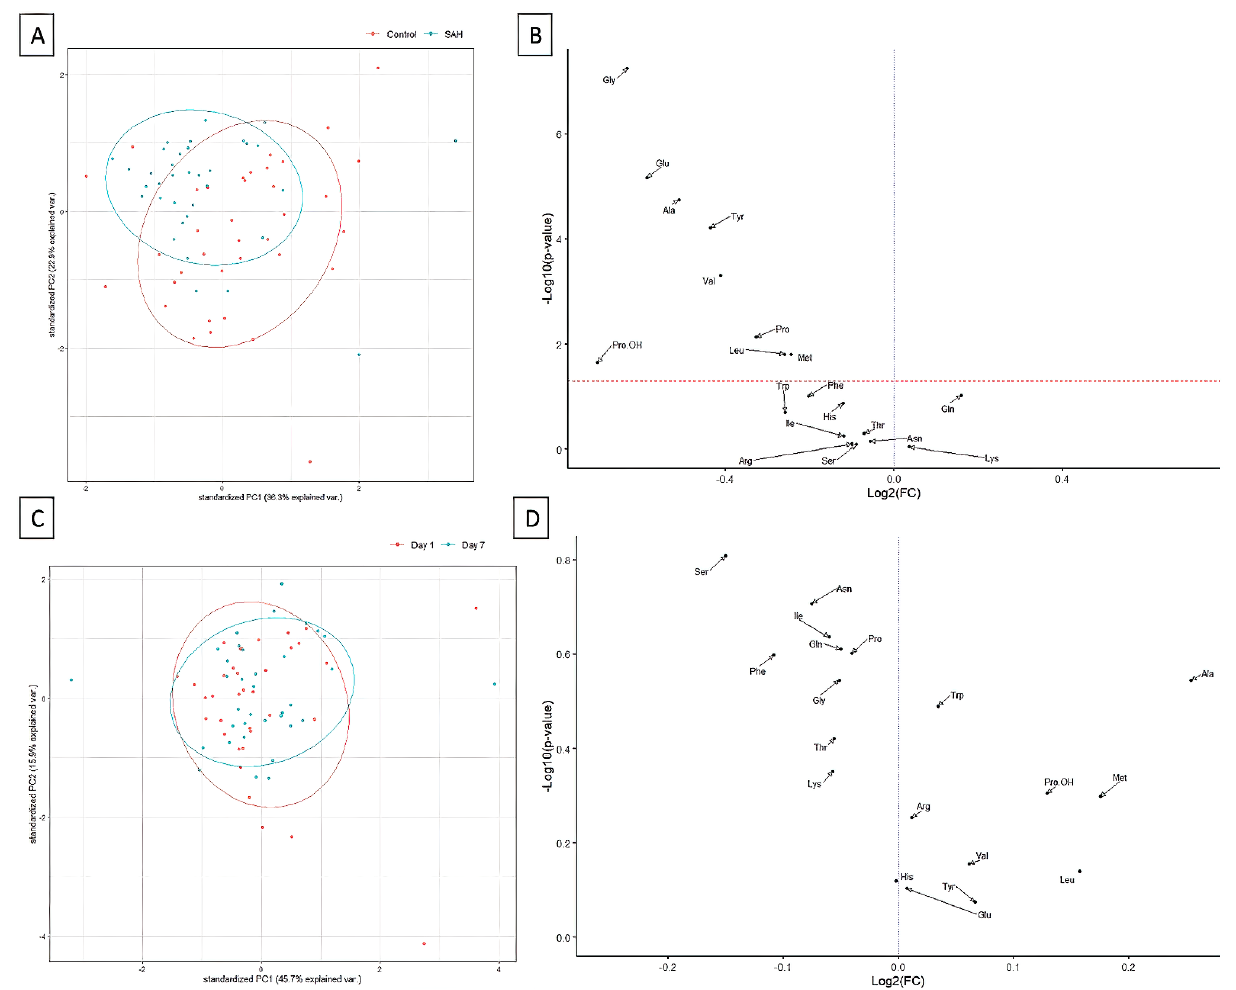
Figure 1. Principal component analysis and differential concentration analysis (volcano plots) show- ing the differences in amino acids concentration between SAH and control patients ( A , B ) and between day one and day seven post-operation ( C , D ). The relevant p -values are available in Table 4.